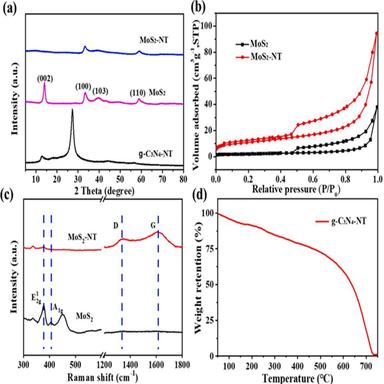
XRD patterns of g-C3N4-NT, MoS2 and MoS2-NT (a), N2 adsorption and desorption isotherms (b) and Raman spectra (c) of MoS2 and MoS2-NT and TGA curves of g-C3N4- NT (d).